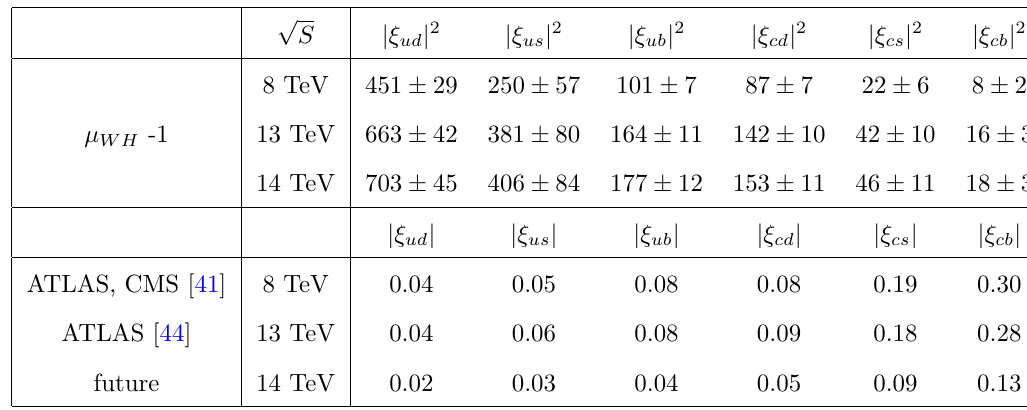
p S = 8 TeV, 13 TeV, and 14 TeV, and